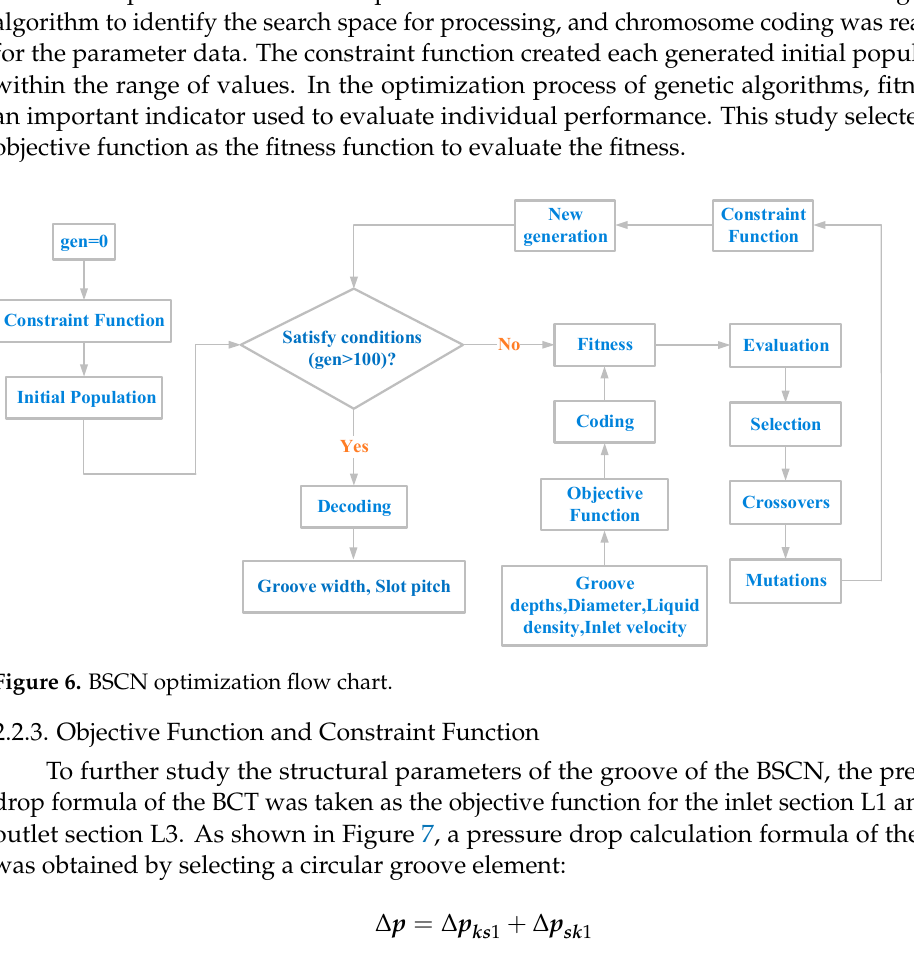
Figure 5. Concept diagram of BSCN.